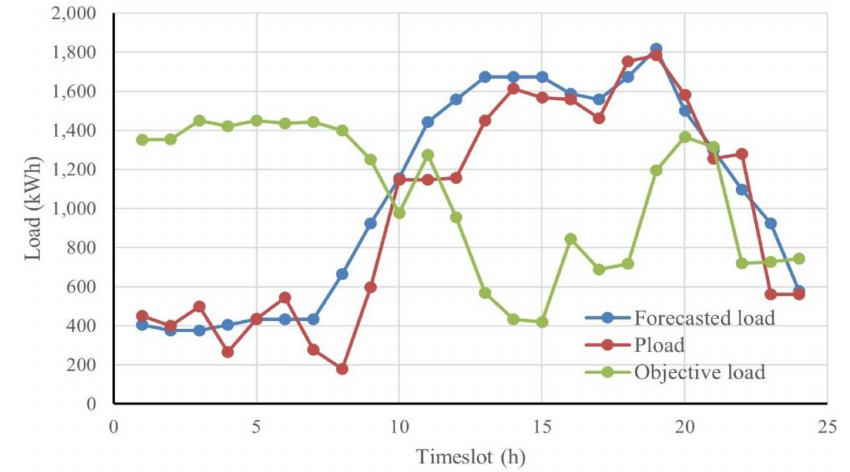
Figure 9. Hourly commercial load before and after shifting using